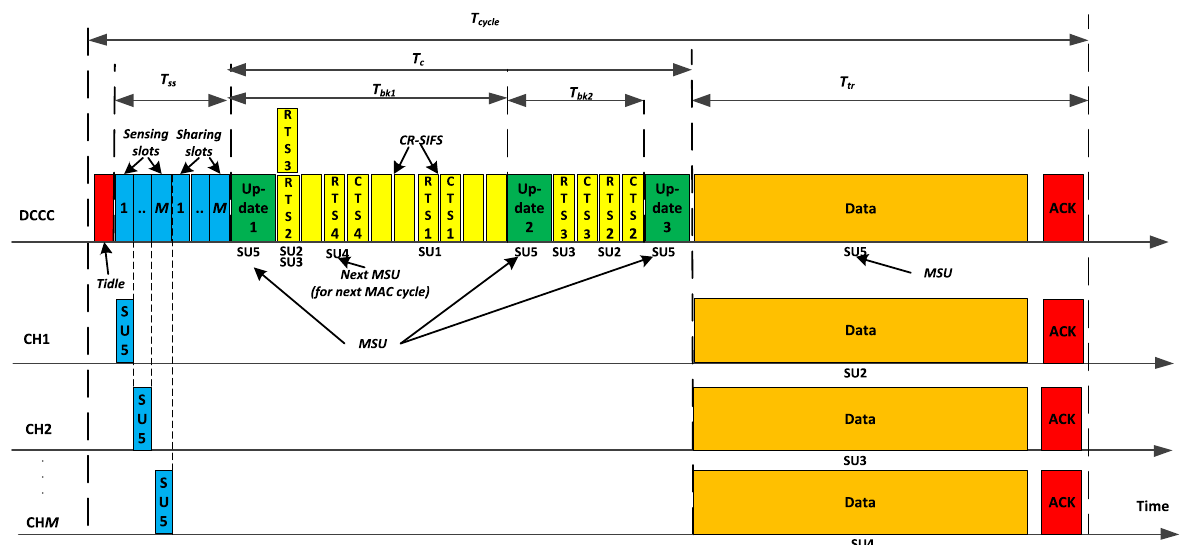
Fig. 4 The operation of the proposed MAC protocol. An example about how the proposed MAC protocol